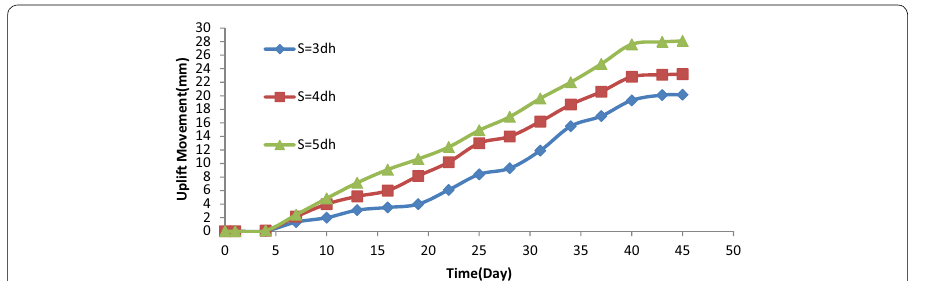
35 and double helix (dh =